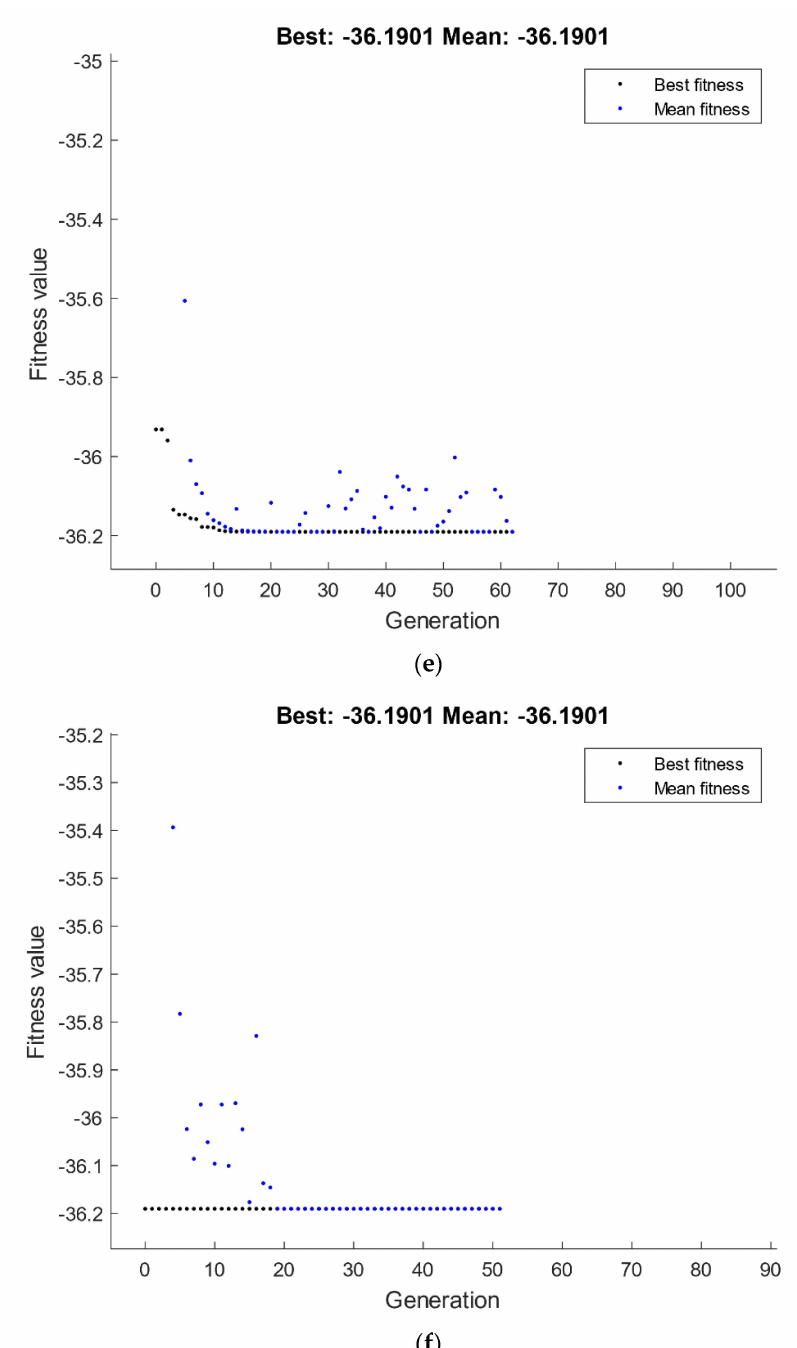
Figure 15. Optimum tensile response YS ( a , b ), TS ( c , d ), and D% ( e , f ) by GA ( a , c , e ) and hybrid RSM-GA ( b , d , f